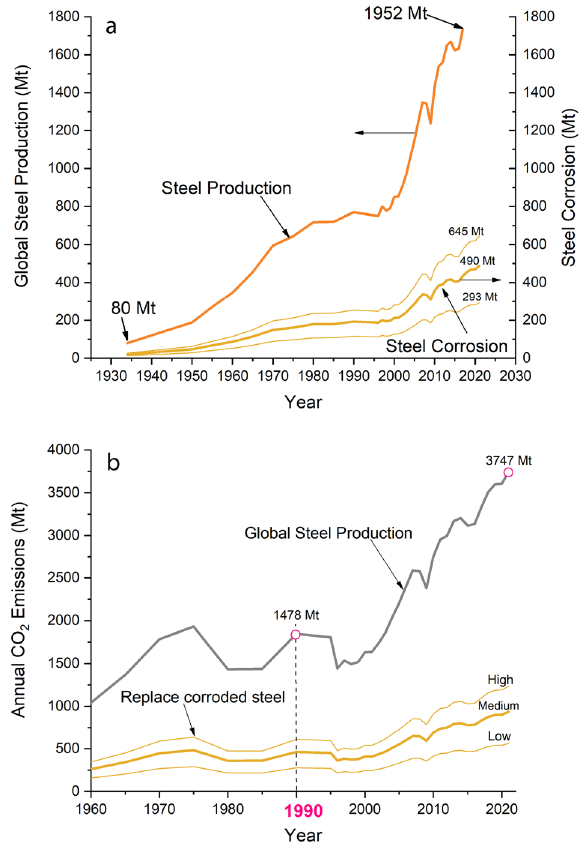
Fig. 1 In fl uence of steel production and corrosion on CO2 emissions. Global steel production and the corresponding amount destined to replace corroded steel ( a ) and the resulting CO 2 emissions ( b ). The year 1990 is highlighted as it is the bases of the EU target